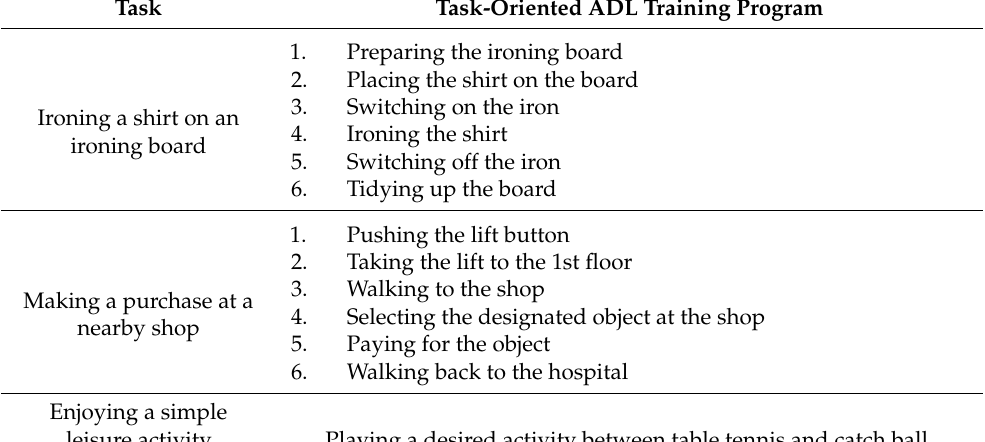
Playing a desired activity between table tennis and catch (table tennis, catch ball)